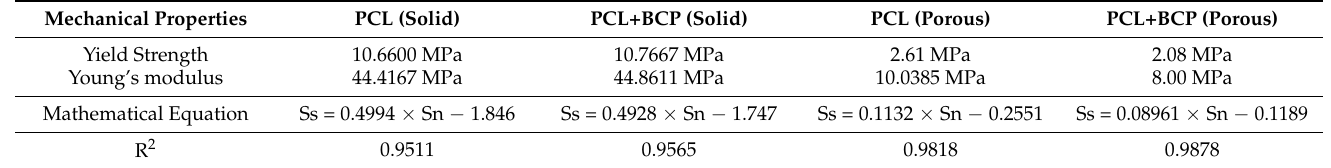
Table 2. Mechanical properties of PCL and PCL+BCP as solid and porous structure.